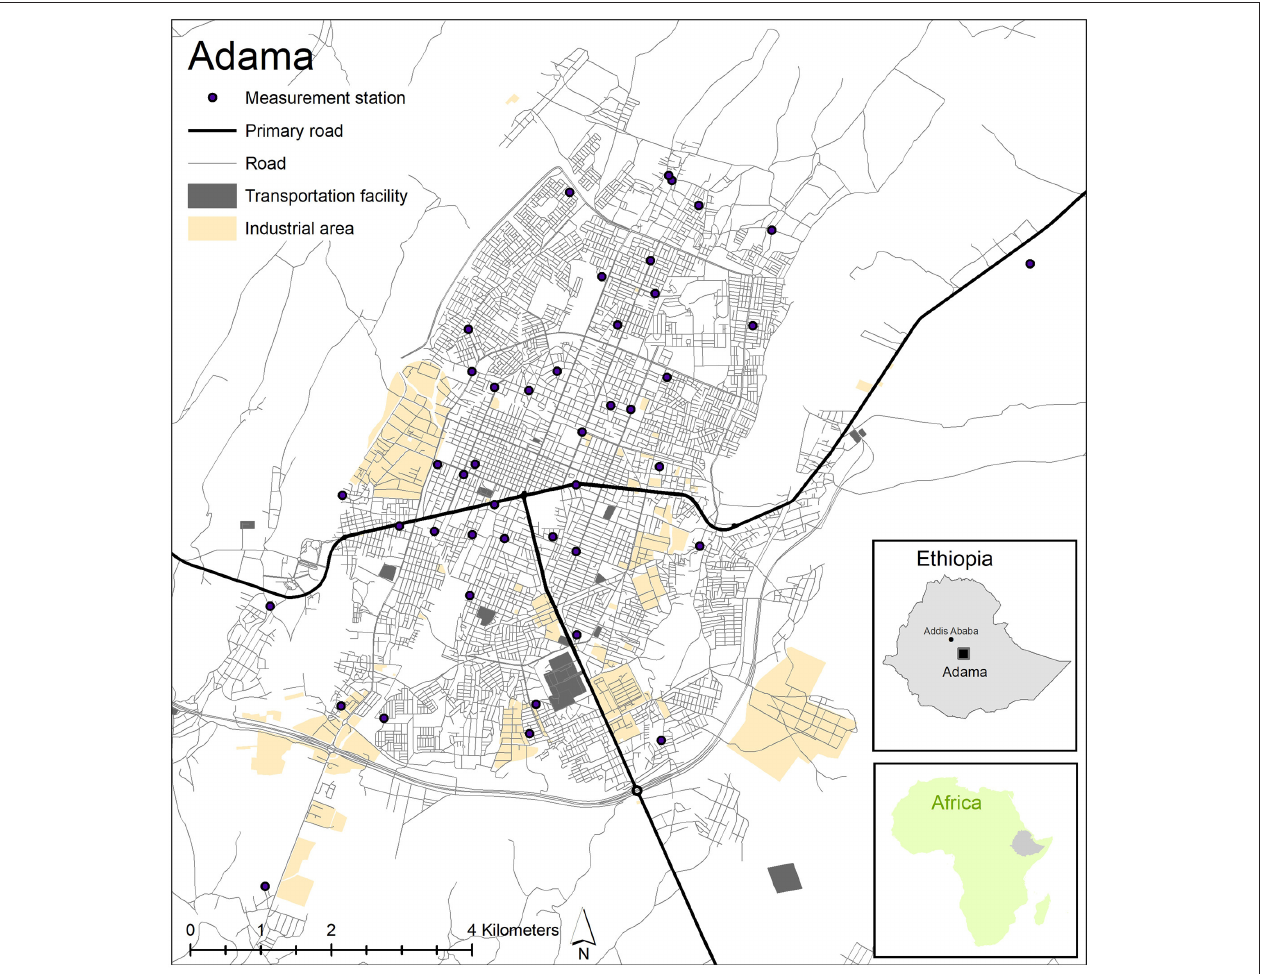
FIGURE 1 | Adama’s geographic location in Ethiopia, its location in east Africa, and the measurement stations and key land-use classifications used for modeling NO 2 and NO x (further discussed in Section 2.4 Exposure